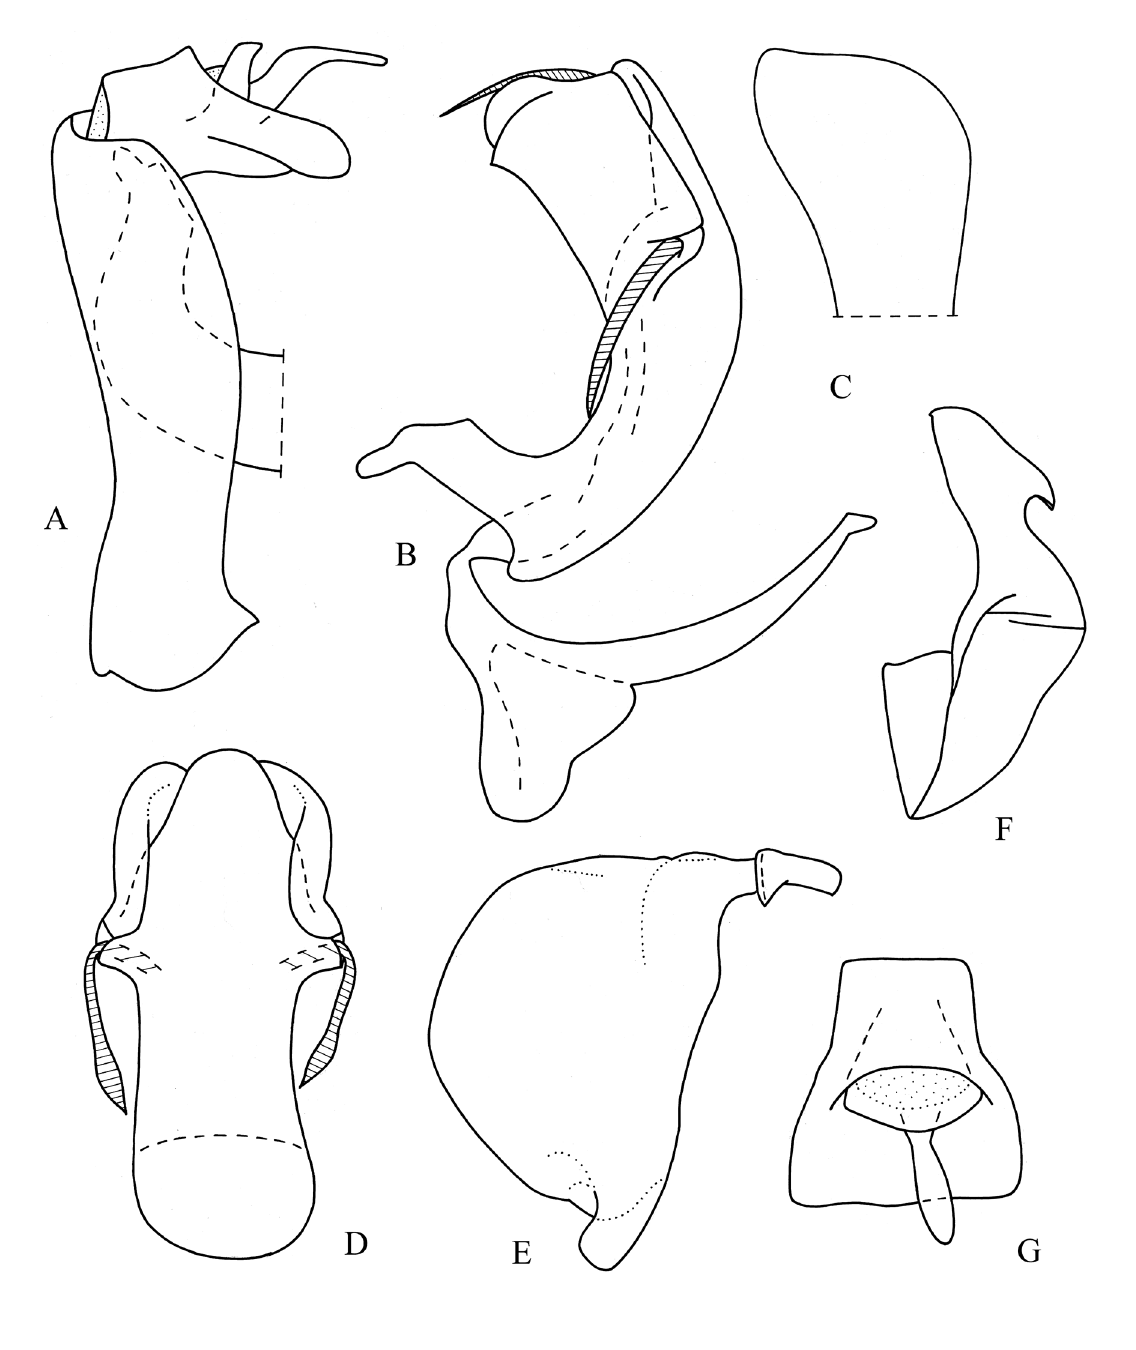
Fig. 5. Superciliaris anichkini sp. nov., ♂, holotype (ZIN), genitalia. A . Pygofer and anal tube, lateral view (basal part of penis showed by dotted line). B . Penis (aedeagus shaded) and connective, lateral view. C . Apical part of phallobase inflated in water. D . Penis, ventral view. E . Style, lateral view. F . Style, dorsal view. G . Anal tube, dorsal view. No to